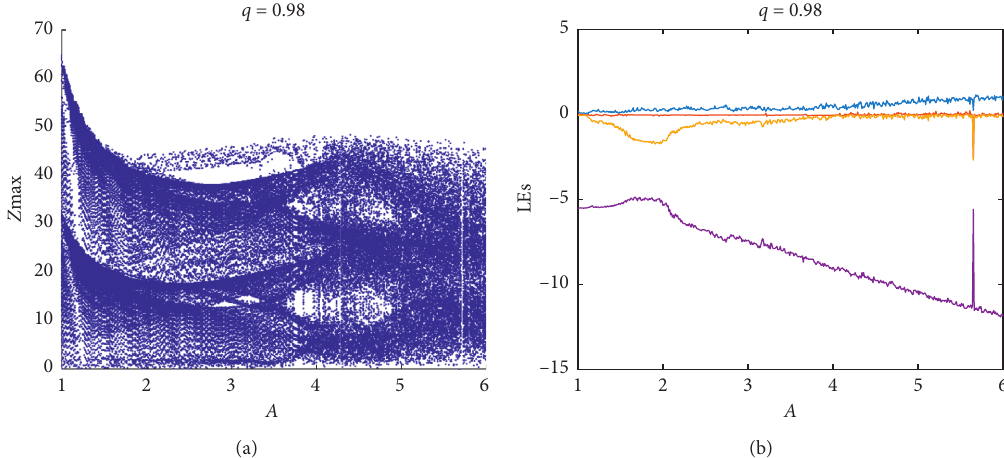
Figure 4: (a) Bifurcation diagram of parameter A of system (1) with q � 0.98; (b) Lyapunov exponent spectrum of parameter A of system (1) with q � 0.98.